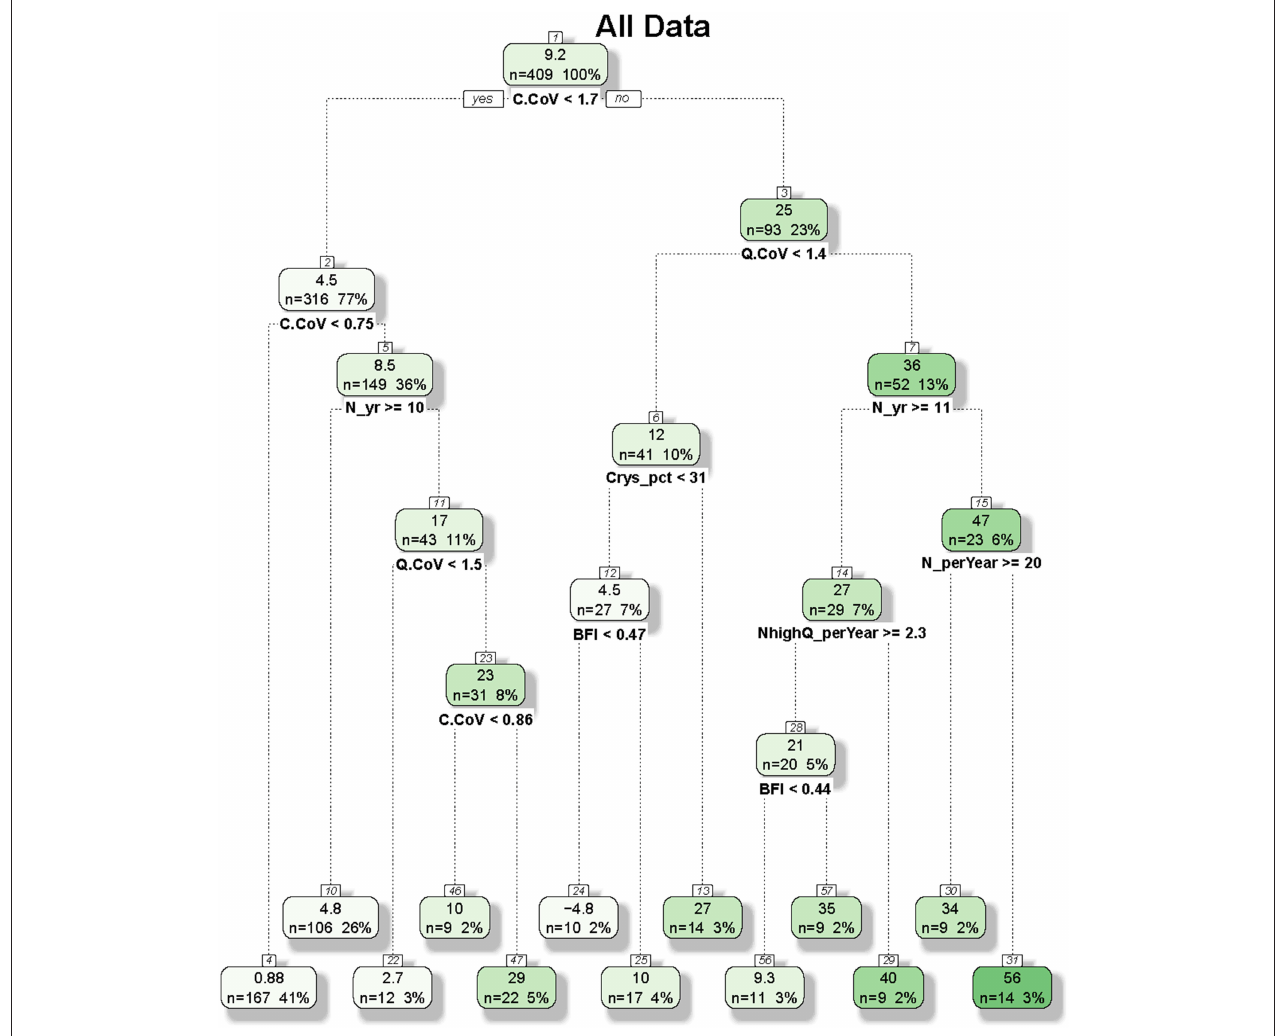
FIGURE 5 | Regression and classification tree developed for constituent flux bias for all site-constituent combinations. In each node, the top number represents the average bias (percent) of cases and the bottom numbers represent the number of cases and the percentage of cases (in bracket). Of the 425 cases for all site-constituent combinations, 16 were excluded due to missing values in land use and/or geology